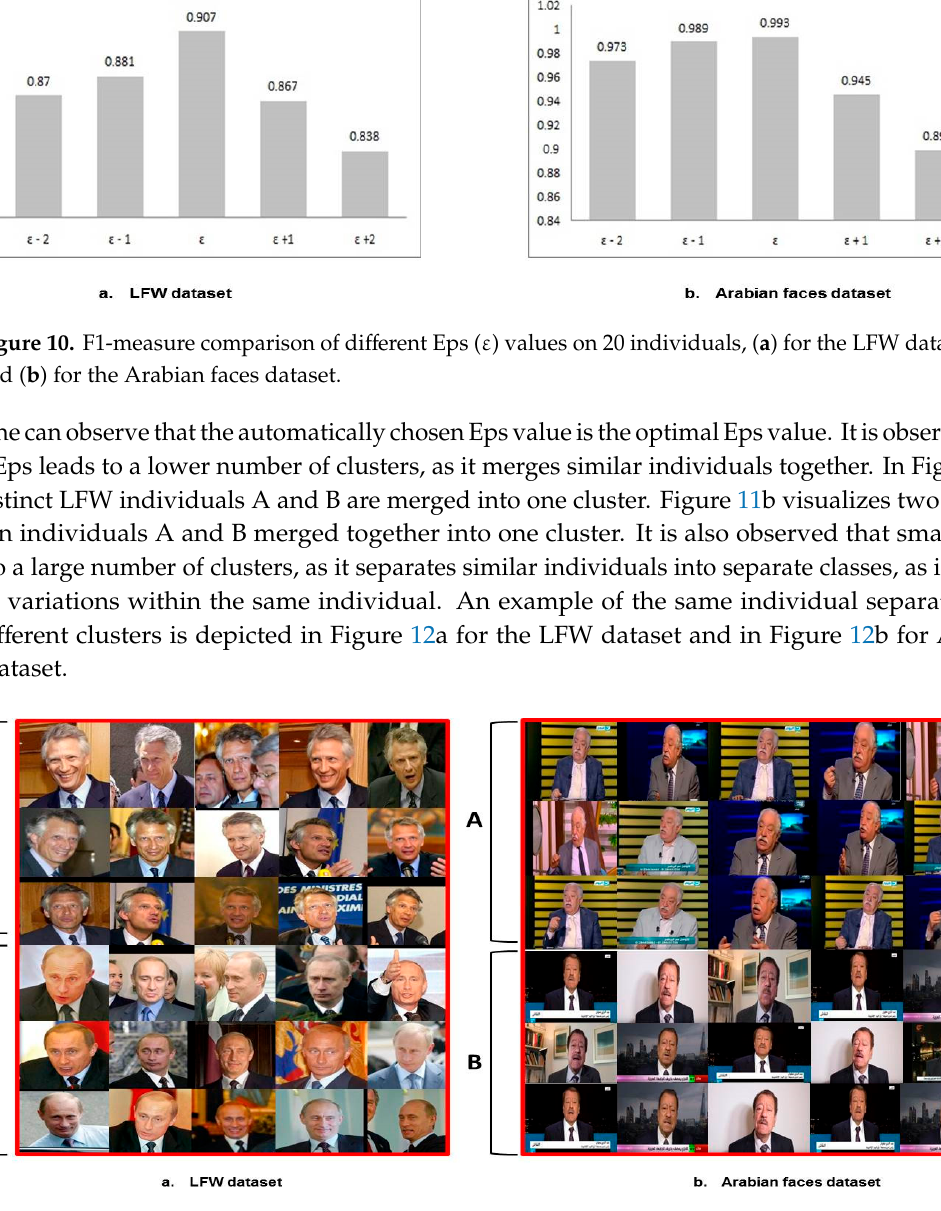
Figure 11. Sample of merged clusters, ( a ) for the LFW dataset and ( b ) for the Arabian faces dataset.